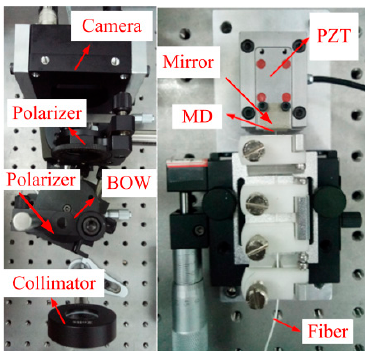
Figure 8. Experimental configuration.